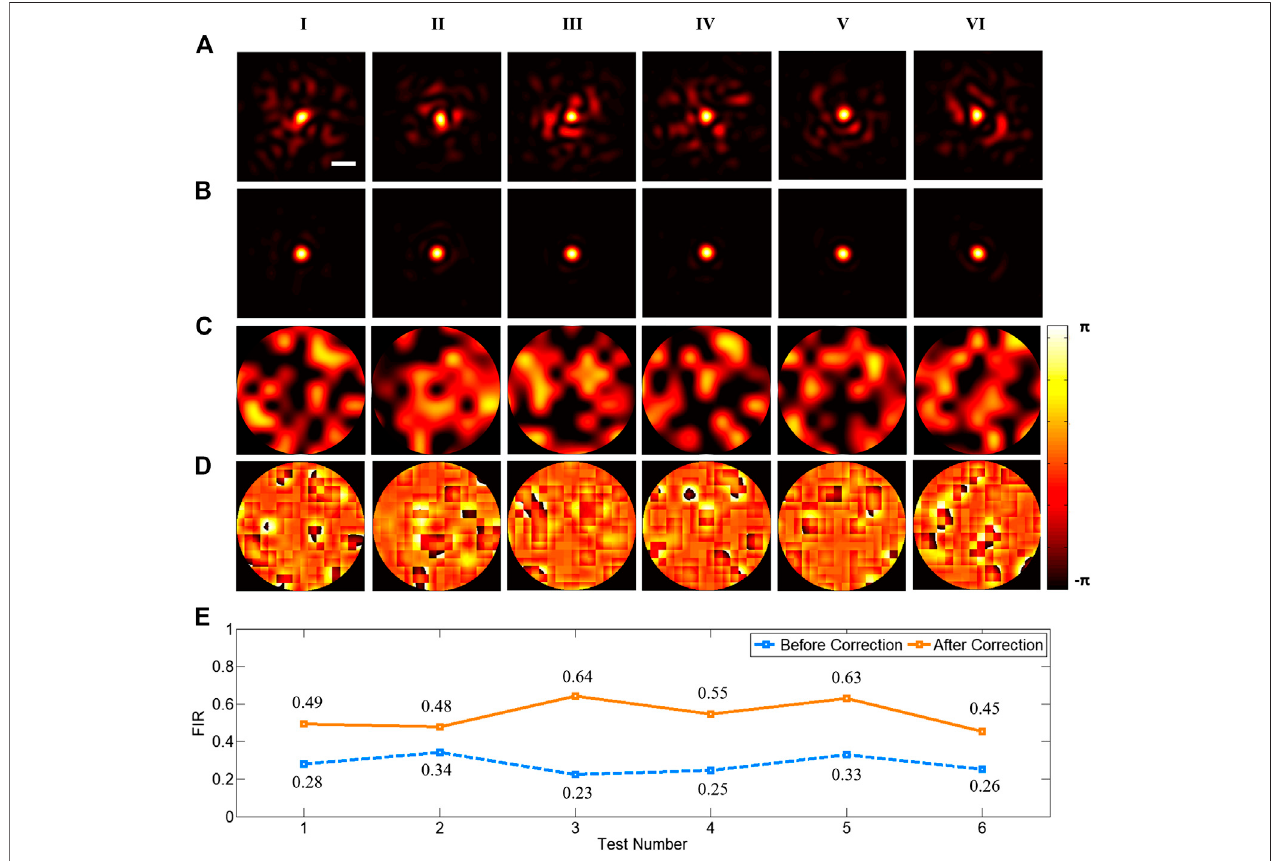
FIGURE 3 | (A) The six distorted PSFs before correction (scale bar: 1 μ m). (B) The six corrected PSFs after DLZAC. (C) The six phase wavefronts before DLZAC. (D) ThesixresidualphasewavefrontswithinthepupilafterDLZAC.Eachcolumnof( A – D )correspondstooneofthesixtestexamples. (E) TheFIRstatisticsofthePSFsin ( A ) and ( B